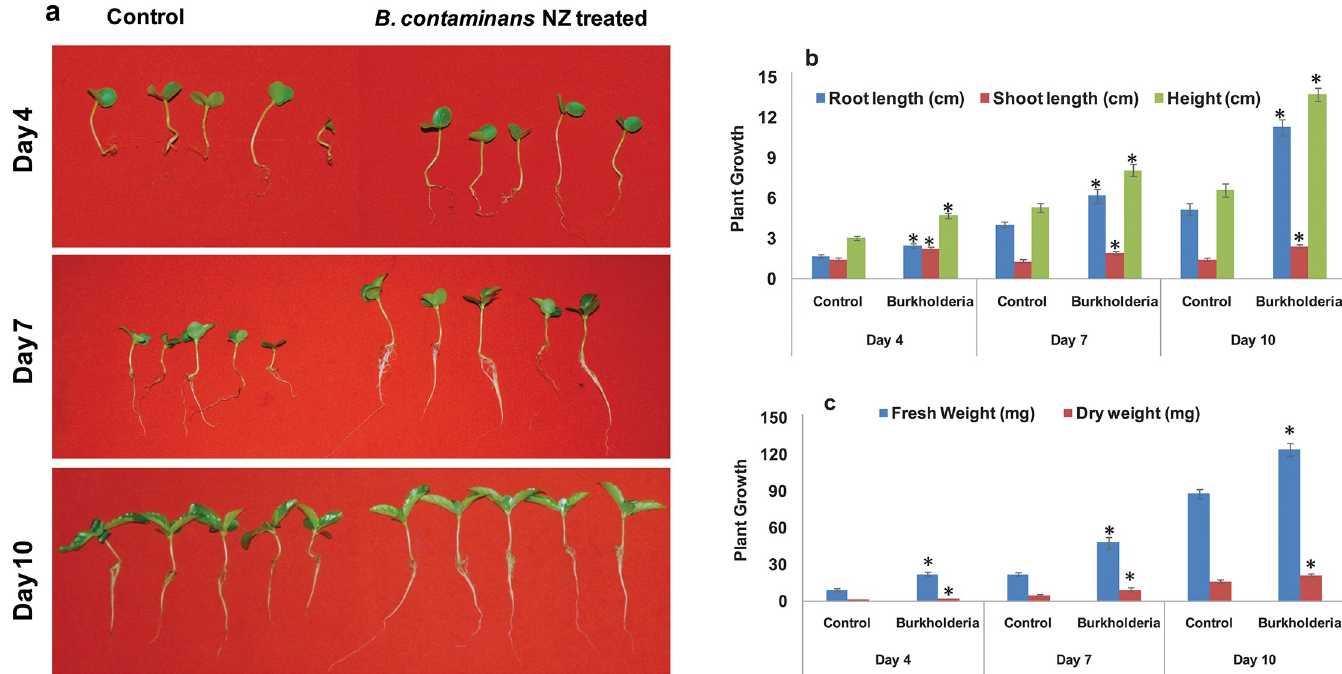
Fig 1. In vivo effect of plant growth promoting endophytic bacteria B . contaminans NZ. (a) Bacterial effect significantly influences the increase in root and shoot lengths of jute seedlings when compared with the control jute plants at 4, 7, and 10 days. Comparisons of (b) shoot and root lengths, plant heights, and (c) fresh and dry weights of B . contaminans NZ-treated and control jute seeds. Error bars represent the standard error of the mean of the replicates. Shoot and root lengths are represented in cm, and fresh and dry weights in mg. Asterisk ( � ) denotes the difference between control and endophyte-treated samples at a significance level of P � 0.05, as determined by ANOVA test. Values are mean(s) ± SD.